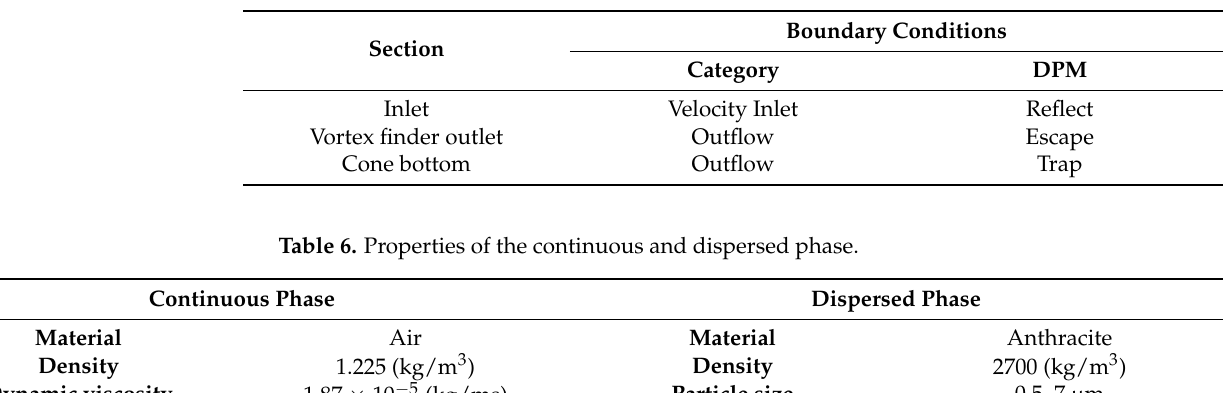
Table 5. Boundary conditions.